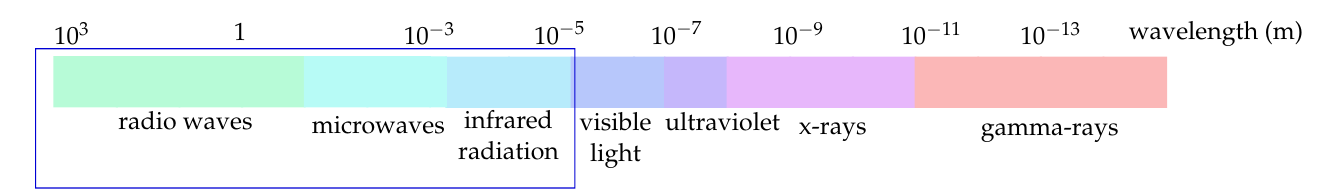
Figure 1. Electromagnetic